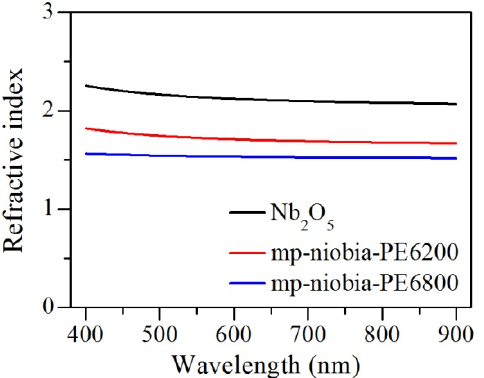
Figure 2. Dispersion curves of dense and porous Nb 2 O 5 after annealing at 320 °C for 30 min.